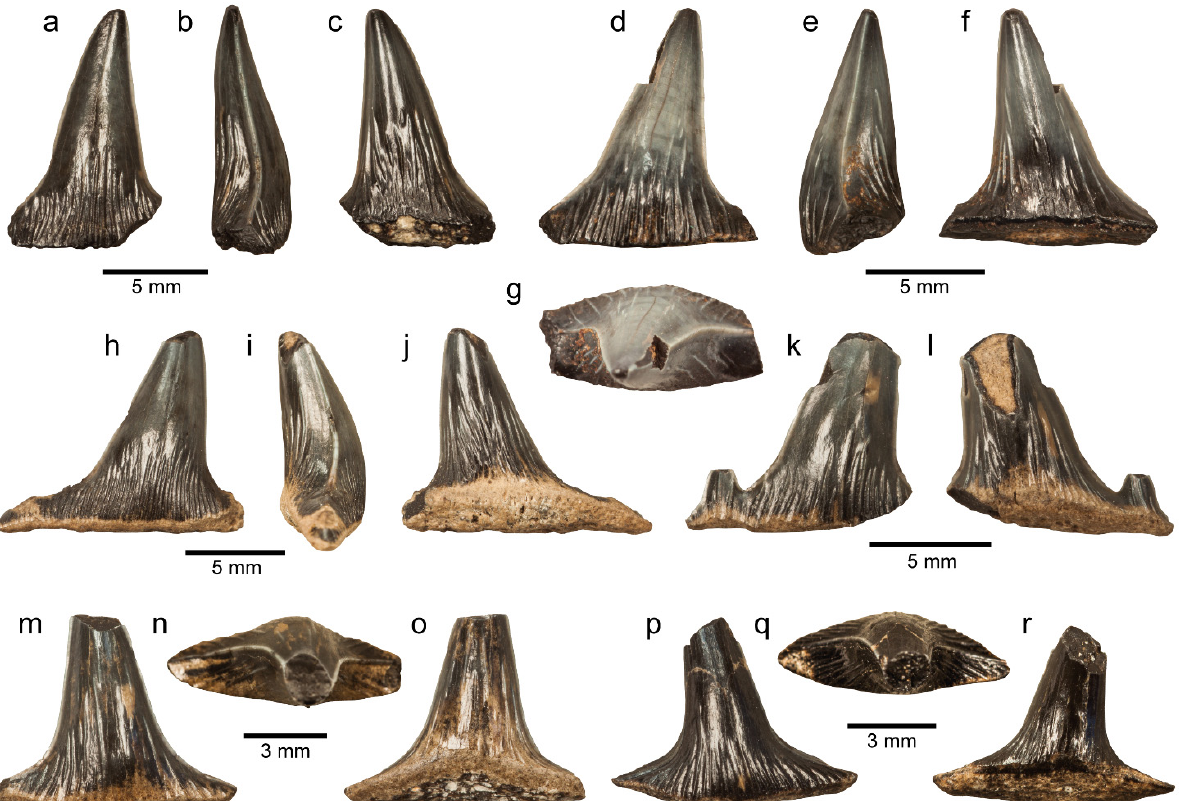
Figure 2. Historically collected hybodontiform teeth from the lower Kimmeridgian of Czarnogłowy, Poland. ( a – l ) Planohybodus sp., GG 303/1 in ( a ) labial, ( b ) mesial and ( c ) lingual view; GG 303/2 in ( d ) labial, ( e ) distal, ( f ) lingual and ( g ) apical view; GG GG303/3 in ( h ) labial, ( i ) mesial and ( j ) lingual aspect; GG 303/4 in ( k ) labial and ( l ) lingual view. ( m – r ) cf. Meristodonoides sp., GG 303/17 in ( m ) labial, ( n ) apical and ( o ) lingual aspect; GG 303/18 in ( p ) labial, ( q ) occlusal and ( r ) lingual view.